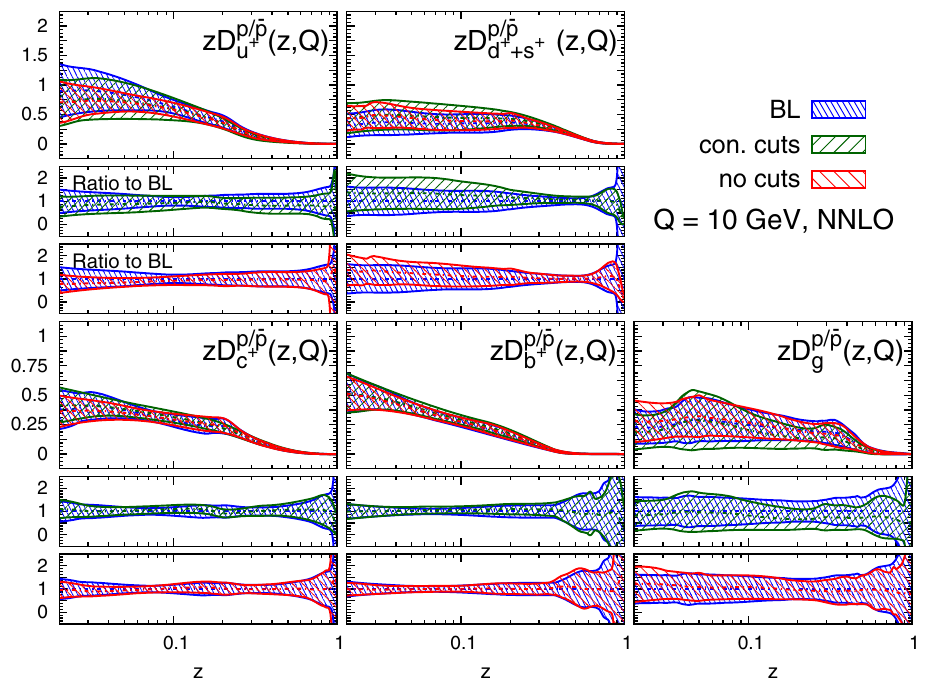
Fig. 19 Same as Fig. 17, but for the sum of protons and antiprotons, p / ¯